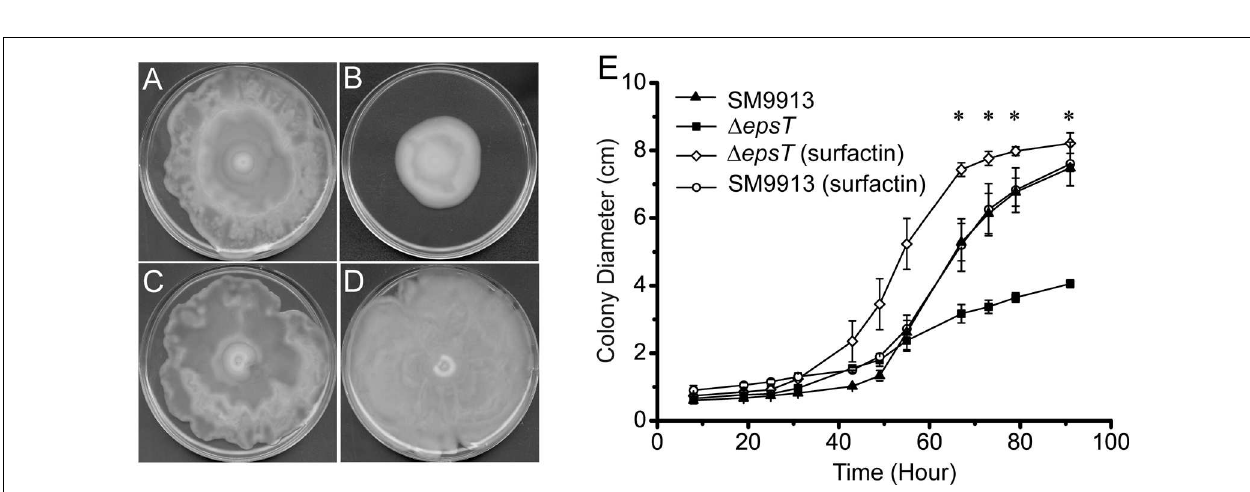
FIGURE 6 | The rescue of the swarming of (cid:49) epsT with surfactin. (A) Wild SM9913 on a swarming plate without surfactin. (B) (cid:49) epsT on a swarming plate without surfactin. (C) Wild SM9913 on a swarming plate with surfactin. (D) (cid:49) epsT on a swarming plate with surfactin. Five microliters of surfactin (2 mg/ml) were dropped onto the center of the plate before inoculation. (E) Colony diameters of wild SM9913 in (A) and (C) and (cid:49) epsT in (B) and (D) . Data were from three independent experiments with at least three replicates (mean ± SD). P -value was calculated from t -test and the symbol ∗ indicates that the difference in colony diameter between (cid:49) epsT with or without surfactin was significant ( P < 0.001). Pictures are a representative of three independent experiments.